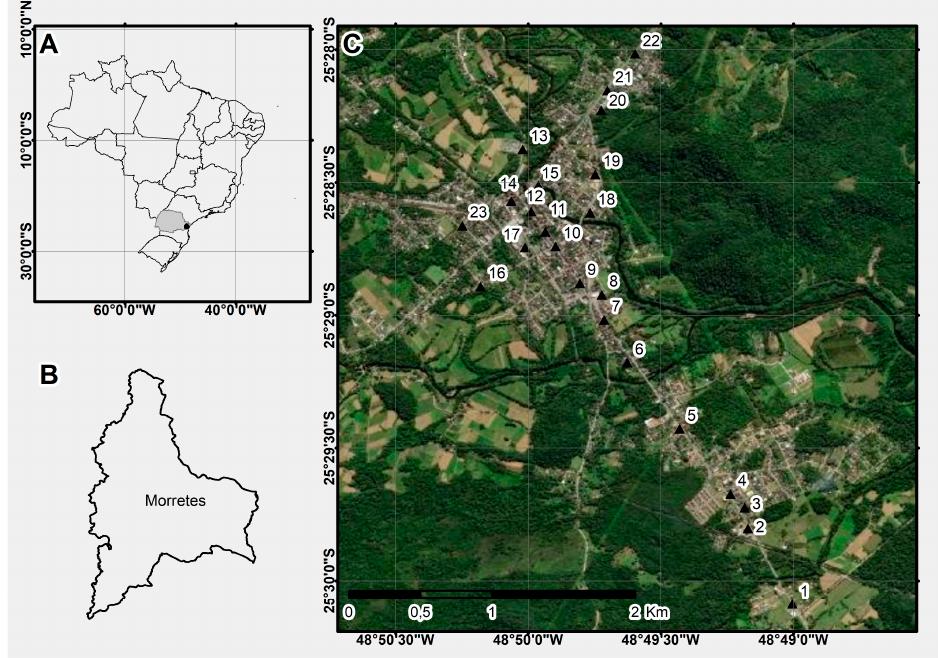
Figure 1. ( A ) State of Paraná with the approximate location of Morretes; ( B ) Municipality of Morretes, Paraná; ( C ) Collection points (1–23).